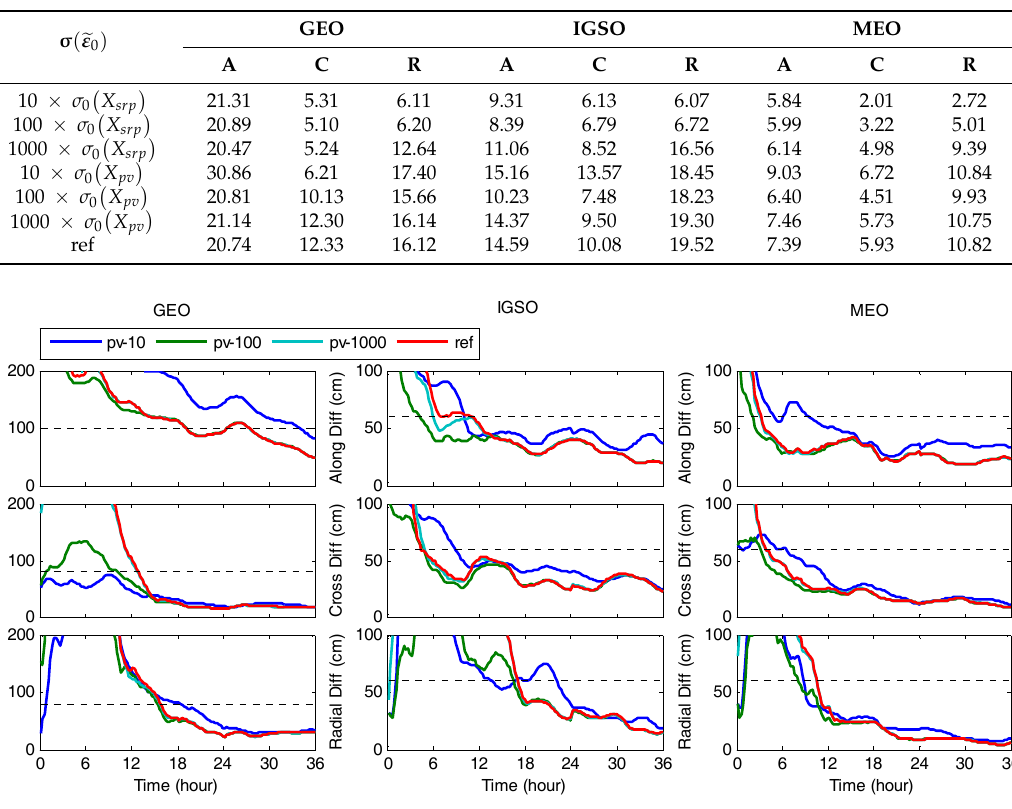
Figure 8. Time series of the average orbit accuracy using different a priori STD of SRP parameters. The BRDC product is used as the initial orbit. The horizontal black dotted line represents the convergence criteria for each direction. The results show that the influence of different a priori STD of SRP and PV parameters in the along-track, cross-track, and radial direction using BRDC as initial orbit is generally consistent with that using UR product. However, the orbit accuracy is lower at the beginning of the filter and the convergence time is longer than that of using the UR product. Besides, the optimal a prior STD magnitude using the BRDC product are about two orders of magnitude larger than that of the UR products, which is in accordance with the orbit accuracy of these two products. Similar to the previous findings, the orbit accuracy becomes worse if the a priori STD is too small (see blue line in Figures 7 and 8). Table 9 gives the optimal a prior STD magnitude of SRP and PV parameters, which use the data in Table 2 as the base value. Moreover, the Time series of the average orbit accuracy using the optimal a prior STD magnitude is plotted in Figure 9. Even when the BRDC was used as the initial value, it can be seen that the orbit accuracy can reach to meter-level